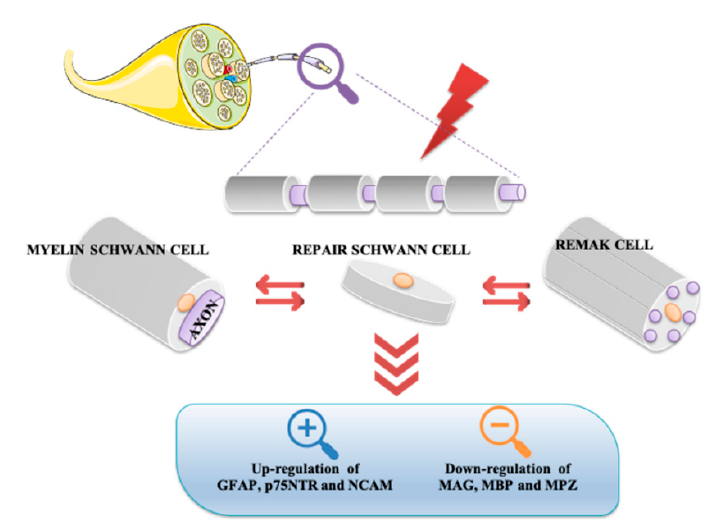
Figure 2. Conversion of myelin Schwann and non-myelin Remak cells into repair Schwann cells after nerve injury. Either in axonotmesis or neurotmesis, repair Schwann cells show up-regulation of GFAP, NCAM, and p75NTR and down-regulation of some myelin genes. GFAP, glial fibrillary acidic protein; MAG, myelin associated glycoprotein; MBP, maltose-binding protein; MPZ, myelin protein zero; NCAM, neural cell adhesion molecule; p75NTR, p75 neurotrophin receptor. During peripheral nerve regeneration, many macrophages infiltrate into nerve damaged area